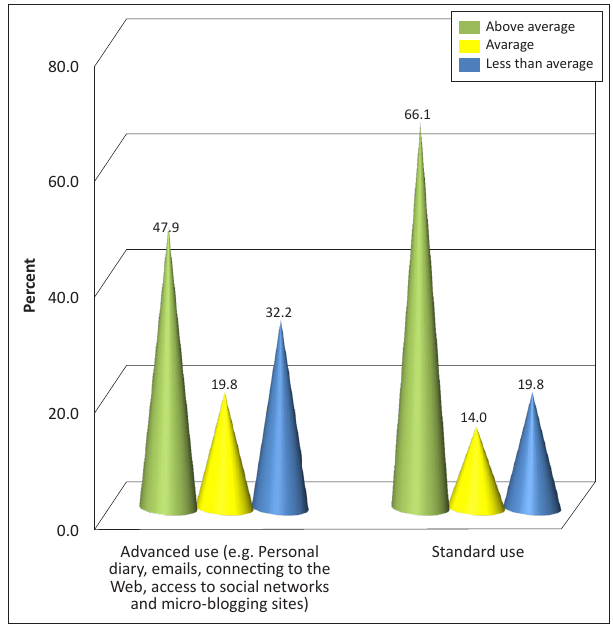
FIGURE 5: Mobile phone usage by South African civil society organisations.